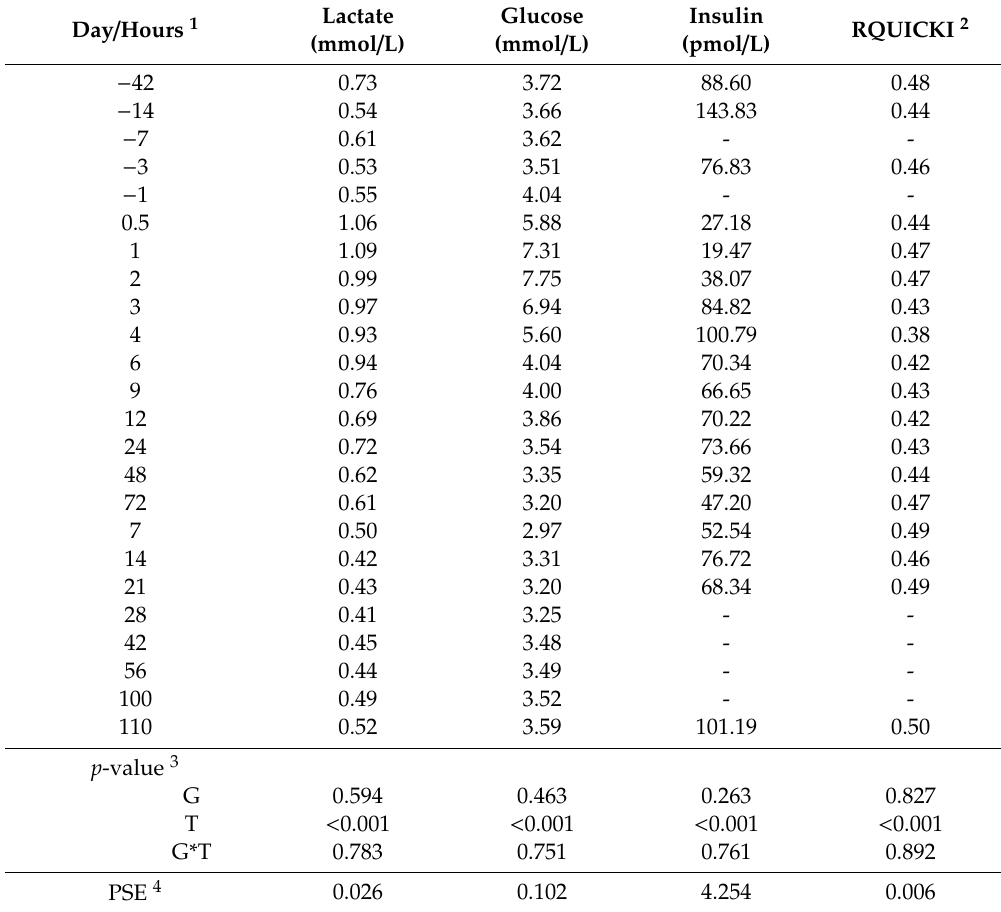
Table A4. E ff ects of L-carnitine supplementation on lactate and glucose in blood, insulin in plasma and Revised Quantitative Insulin Sensitivity Check Index (RQUICKI).